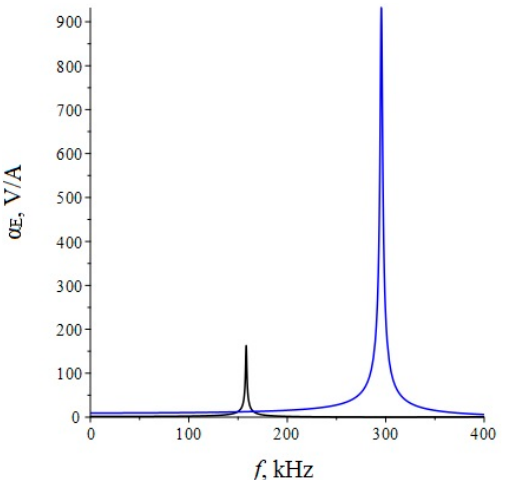
Figure 2. Theoretical dependence of the ME voltage coefficient on the frequency of the alternating magnetic field. Black color of the line is PZT, blue is LN cut y + 128°.